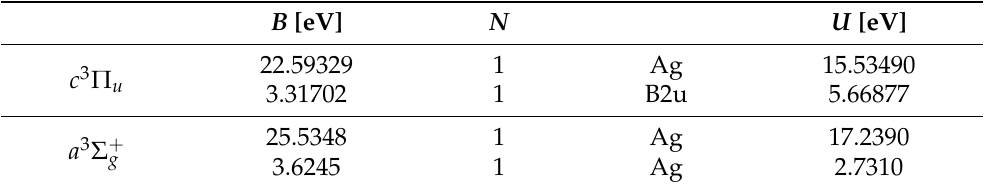
Table 1. Orbital binding energy, occupation number, orbital symmetry, and kinetic energy for distance, i.e., R c eq = 1.0376 Å and R a eq = 0.98879